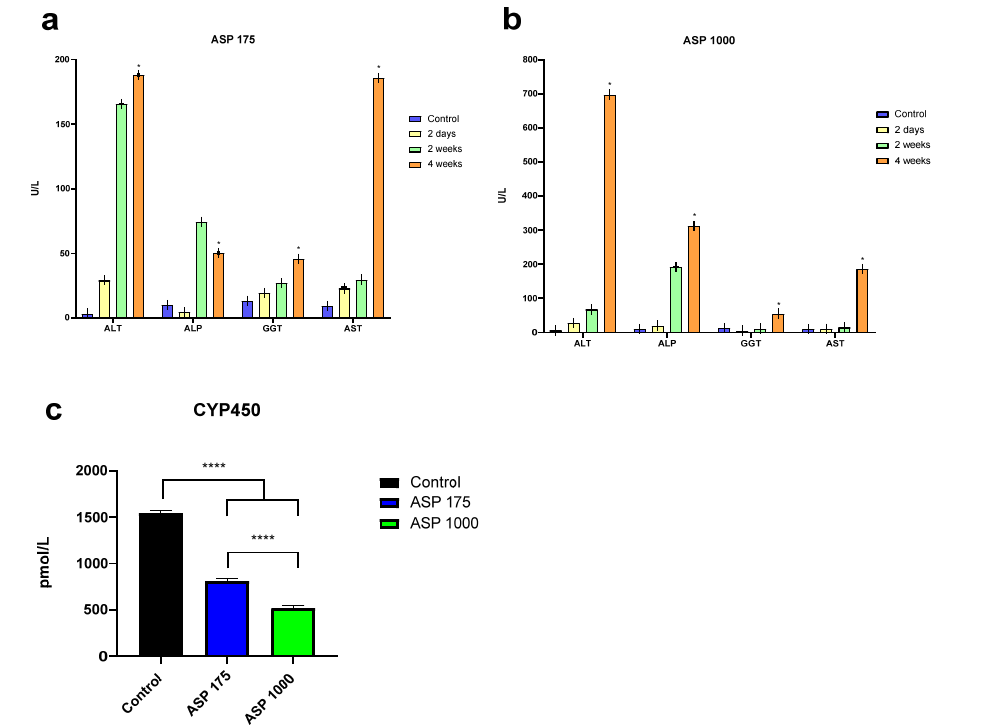
Figure 3. Liver enzyme concentration after four weeks of ( a ) ASP 175 mg/kg/day and ( b ) ASP 1000 mg/kg/day administrated rats, and ( c ) the effect of 4 weeks of ASP 175 and 1000 mg/kg/day on CYP 450 enzyme. Data are shown as mean ± SD ( n = 5). p -values of 0.05 were considered statistically significance, where * p < 0.05 and **** p < 0.0001.